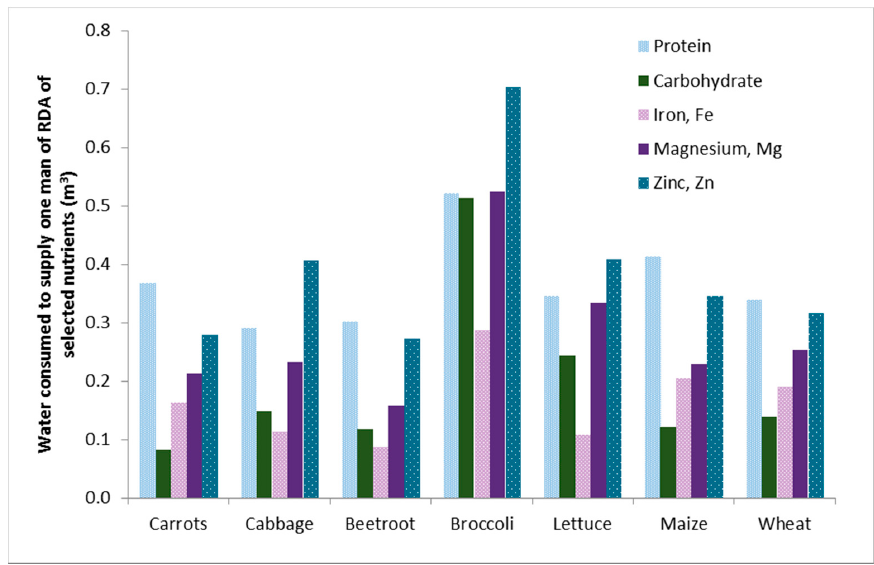
Figure 8. Blue plus green water footprint to supply a man (aged 31–50) with their Recommended Dietary Allowance (RDA) [61] in terms of selected nutrients.